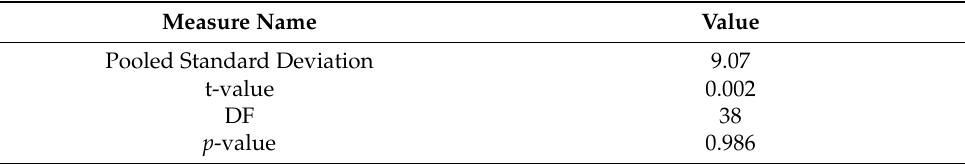
Table 7. Paired t-test summary.